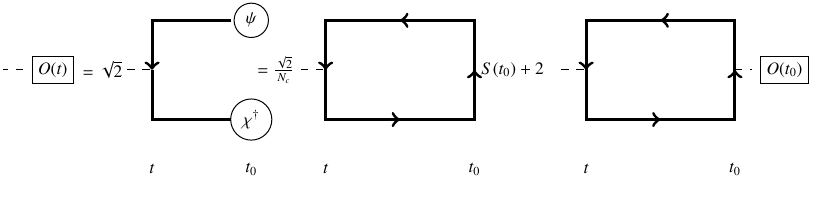
Figure 2. Backwards evolution of the